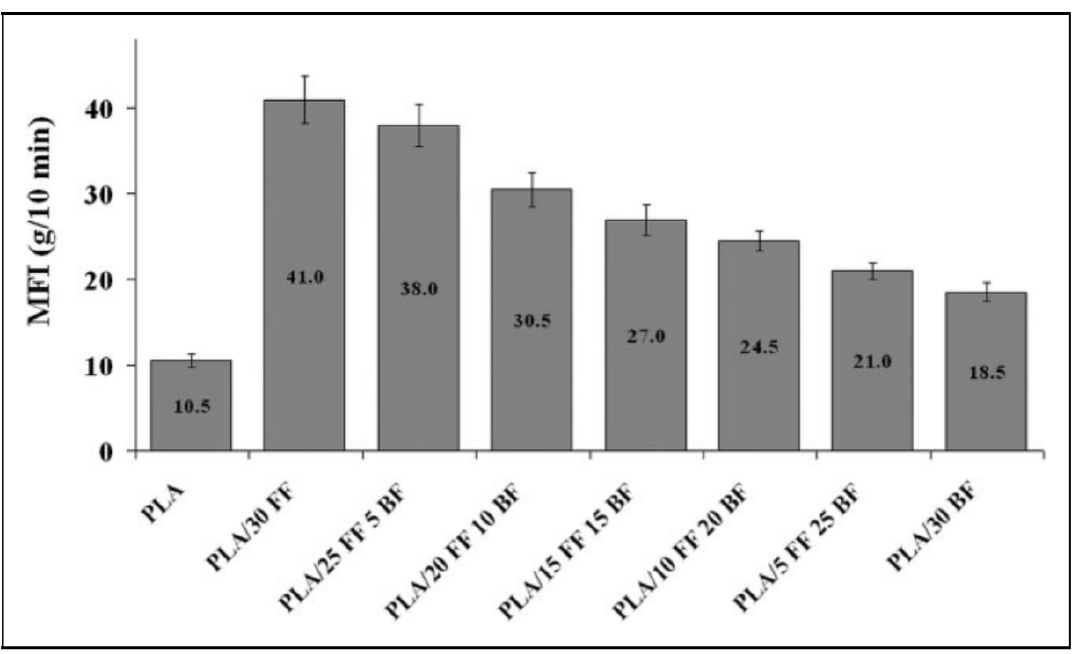
Figure 10. MFI values of PLA and composites. (Copyright permission from Najah Eselini et al. [217].) MFI: melt flow index; PLA: poly (lactic acid); BF: basalt fiber; FF: flax fiber.